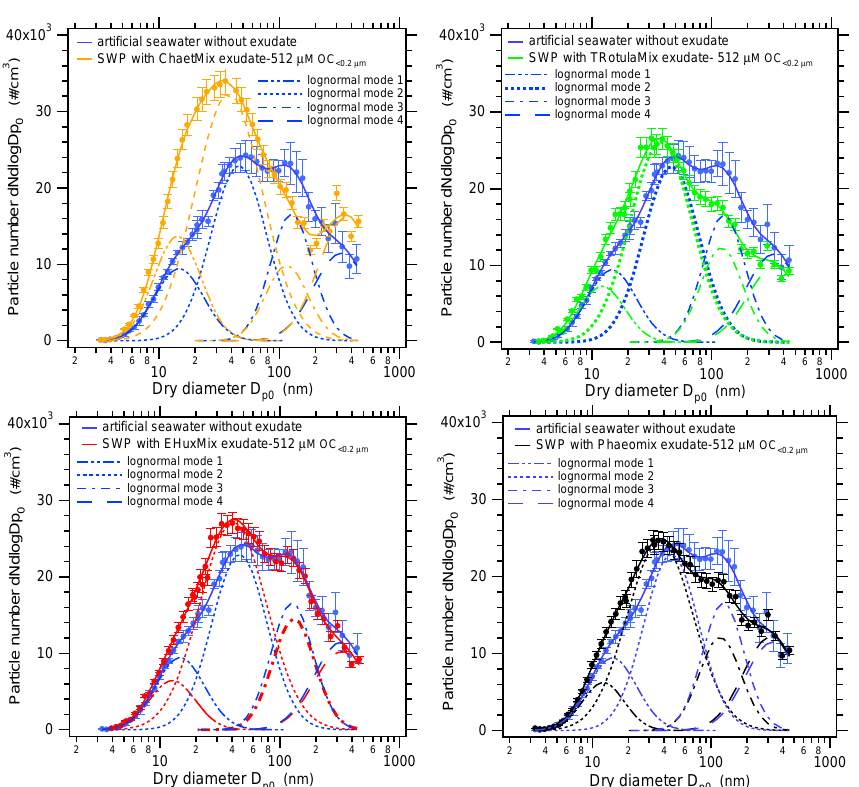
Fig. 11. Particle size distributions obtained for artificial seawater without exudate and seawater proxies enriched with mixtures of different algal exudates at 512µM OC < 0 . 2 µ m concentration. Error bars indicate the variability of the measurements obtained from 6 scans during 1 h period as ± 1 σ standard